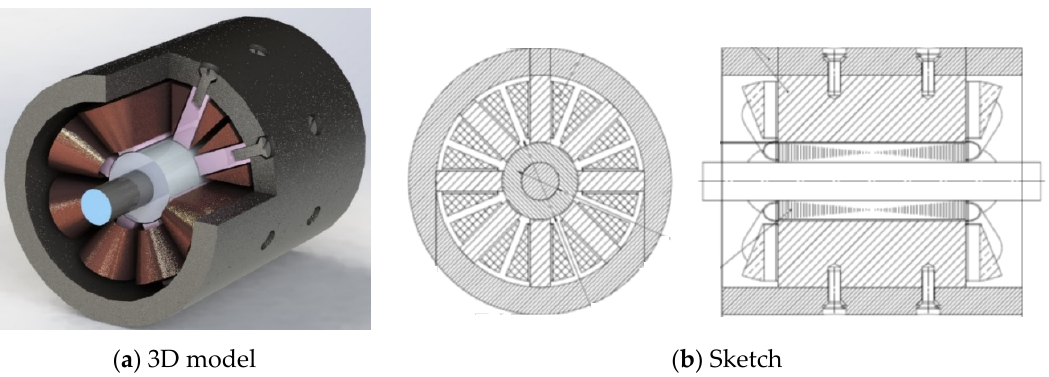
Figure 9. 3D model of the proposed active magnetic suspension and its sketch.